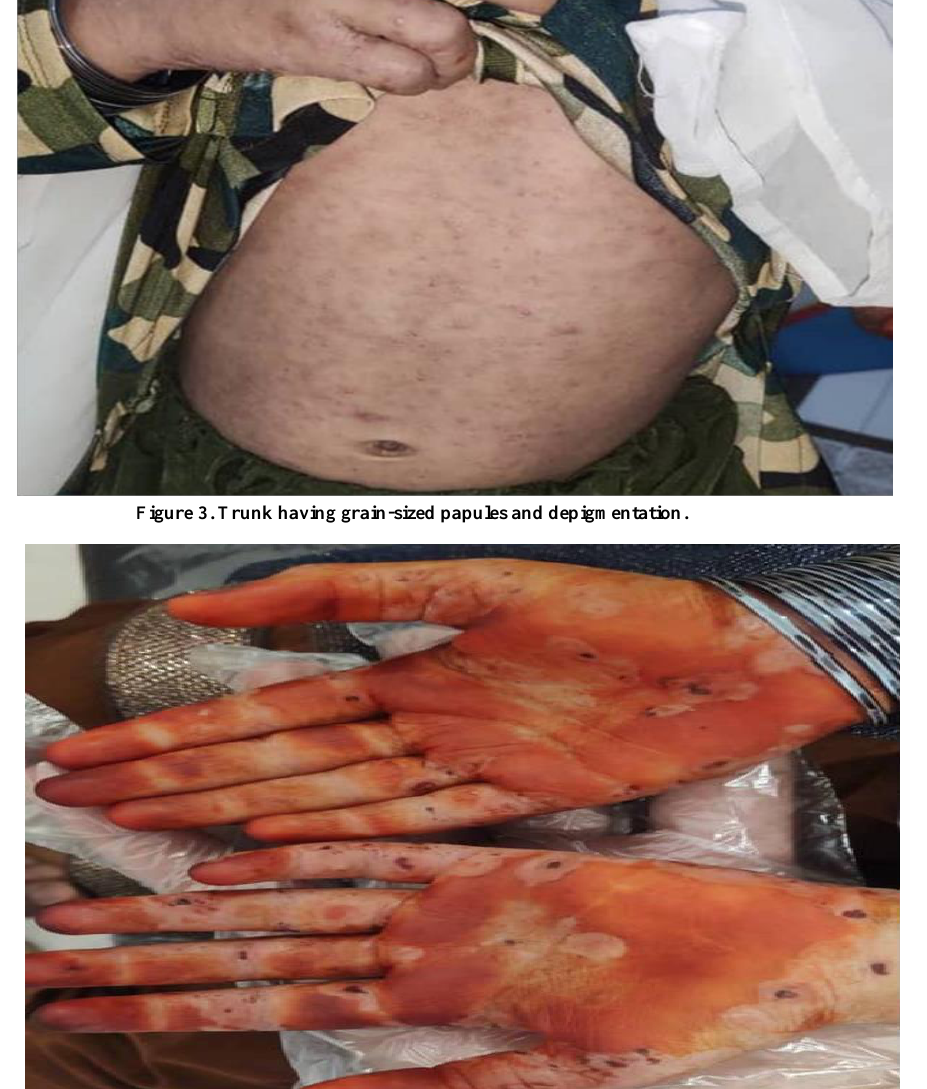
Figure 4. After two weeks of treatment with sulfur and permethrin 5%, most lesions have